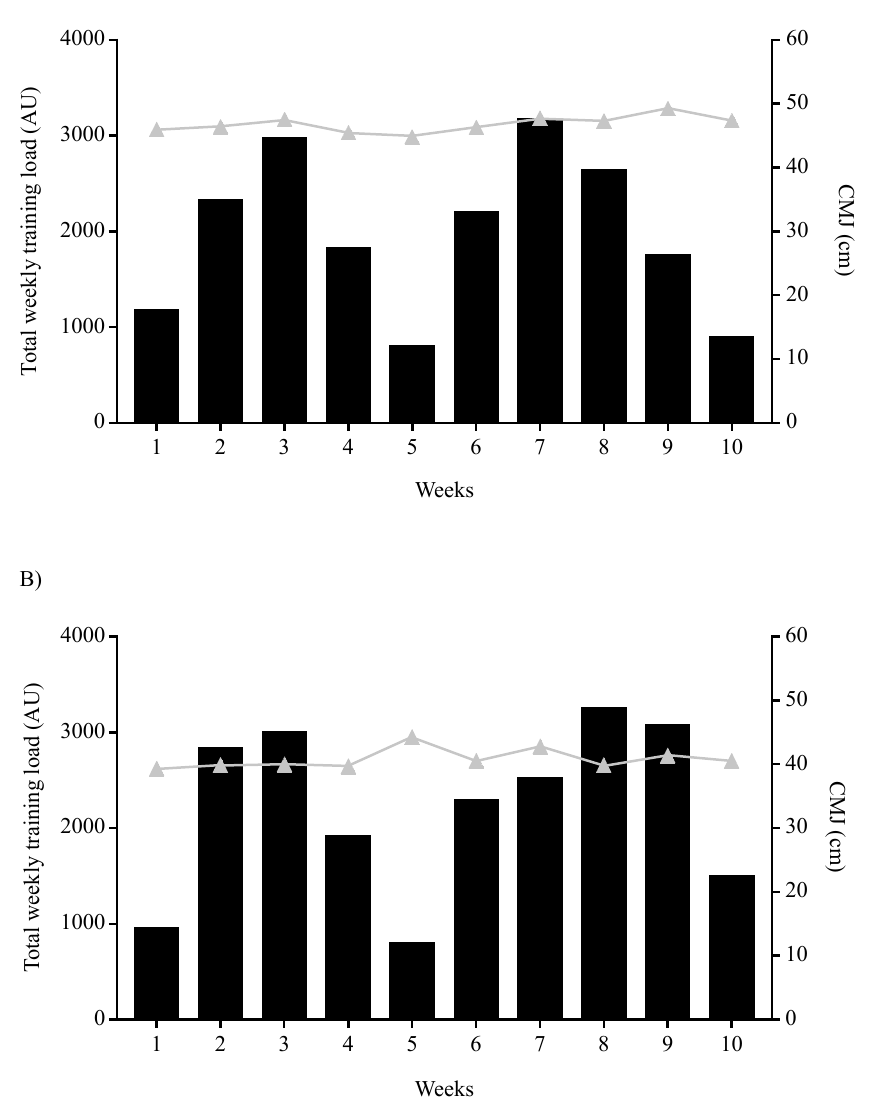
Figure 1. Total weekly training load (TWTL) and explosive power (CMJ) during the 10 analyzed weeks for the defender (A) and blocker